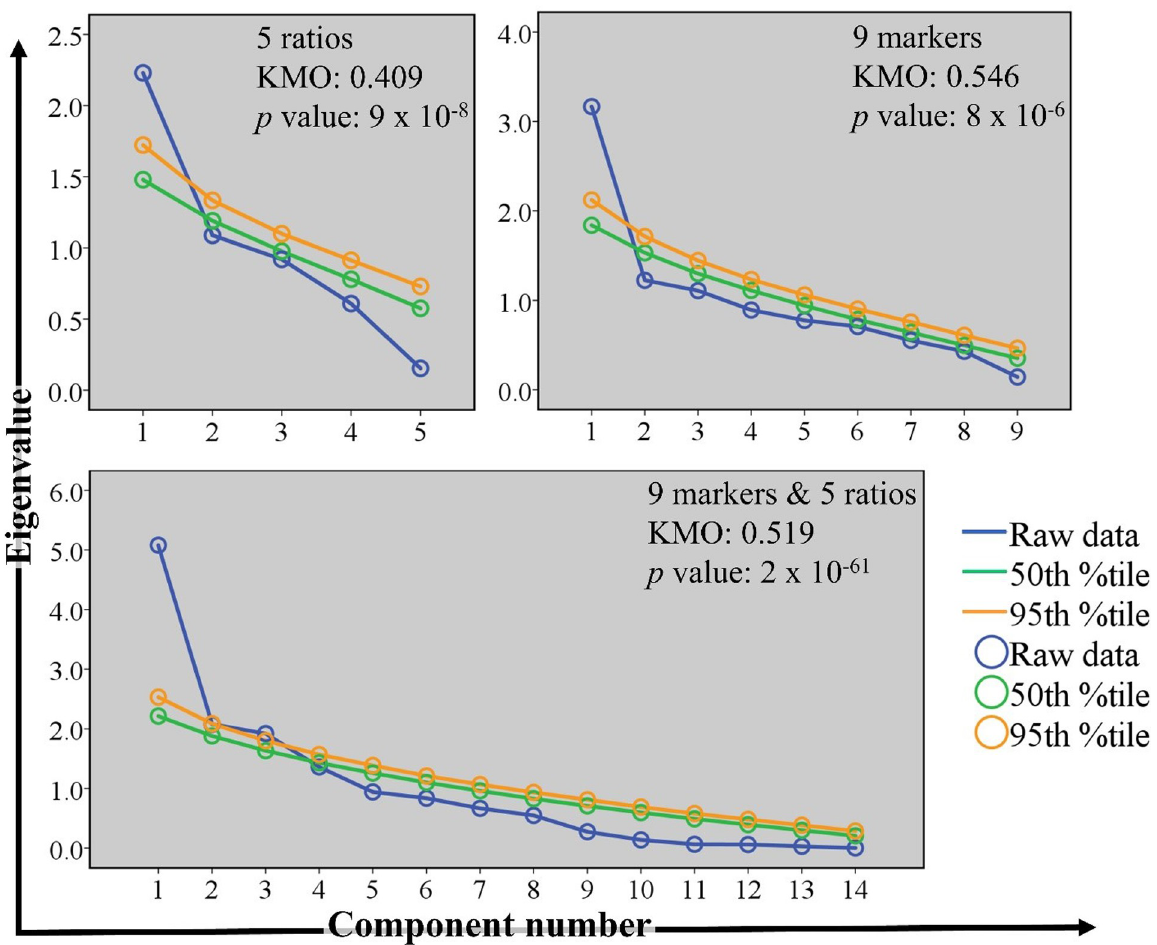
Fig 3. Verification of the suitability of using principal component analysis (PCA). Scree plots were generated using Monte Carlo simulation. The eigenvalues of individual principal components computed from the observed (raw) data were compared to the corresponding simulated eigenvalues. Statistically significant principal components have greater eigenvalues than the corresponding 50 th and 95 th percentile simulated eigenvalues. Kaiser-Meyer-Olkin (KMO) measure of sampling adequacy was used to evaluate sample size. Bartlett’s test of sphericity was used to reject the null hypothesis that the correlation matrices used in PCA were equal to an identity matrix. The p values shown represent the likelihood that the null hypothesis is true. The scree plots correspond to PCA results shown in Fig